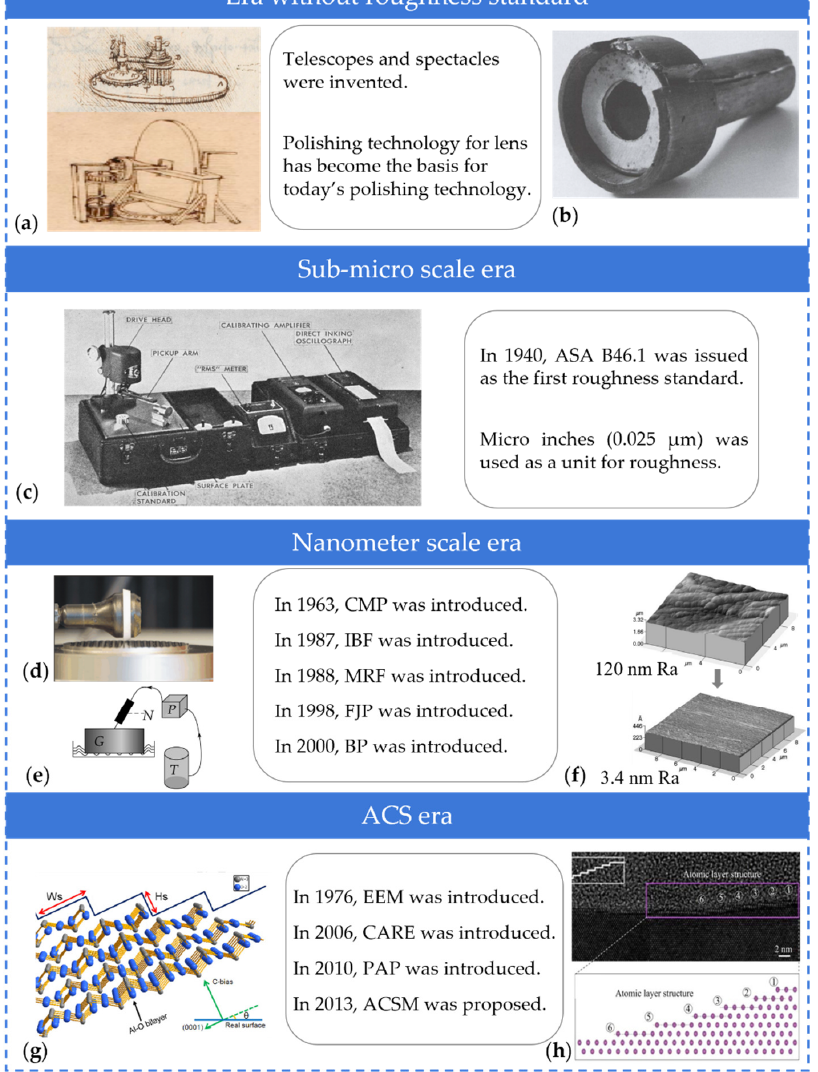
Figure 1. The historical development of roughness scale in polishing technology: ( a ) Leonardo da Vinci drew machines for manufacturing and polishing glass lenses. Reproduced with permission from [18]; ( b ) Galileo Galilei created a lens-polishing apparatus. Reproduced with permission from [19]; ( c ) A